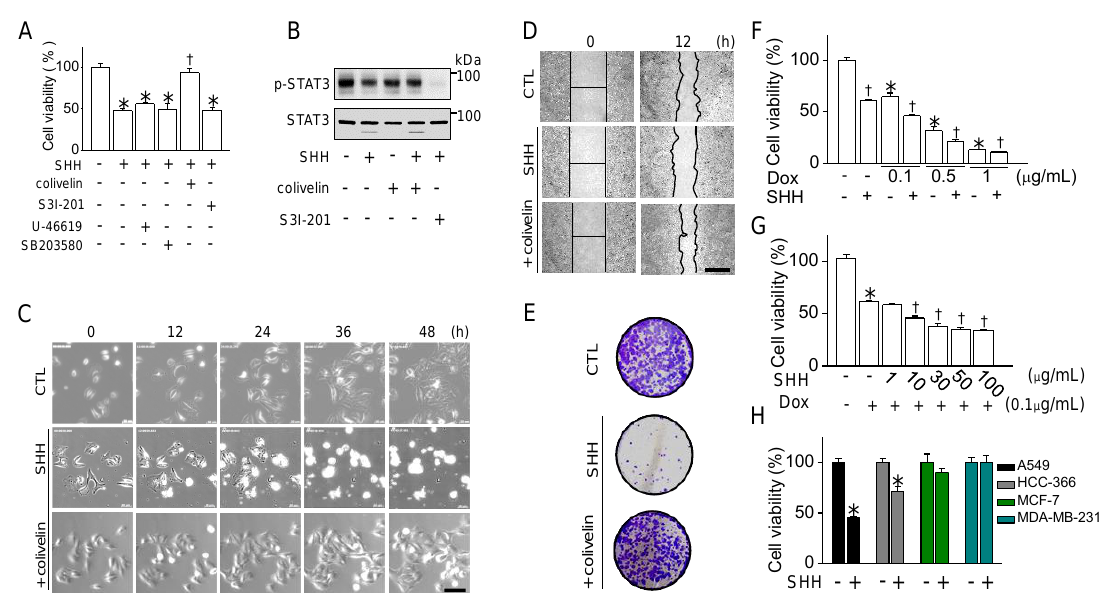
Figure 6. Anti-cancer effect of SHH on A549 cells through inhibition of STAT3 activity. ( A ) Effect of the p38 and STAT3 modulators on SHH-induced cell death. Cells were exposed to SHH (100 μg/mL) for 48 h, and the modulators were pretreated for 1 h. Each bar represents the mean ± SD of four independent experiments ( n = 4). * p < 0.05 compared to the control (no treatment). † p < 0.05 compared to SHH only treatment. ( B ) SHH-induced downregulation of STAT3 activity. SHH was added to A549 cells for 8 h. Total protein (35 μg of protein per lane) was analyzed by immunoblotting assay. ( C ) Real-time images of A549 cells were recorded for 48 h with and without colivelin. ( D ) Effect of colivelin on SHH-induced inhibition of wound healing. Phase-contrast images of wound areas at 0 and 12 h after wounding of A549 cells. ( E ) Reduction of SHH-induced decrease in colony formation of A549 cells by colivelin. Cells were exposed to SHH and colivelin for 48 h. After washing off the chemicals, the cells were further cultured for 10 days for colonization. ( F , G ) Synergistic effect of SHH on doxorubicin-induced cell death. Cells were treated with the indicated concentrations of doxorubicin and/or SHH for 48 h. Different concentrations of doxorubicin ( F ) and SHH ( G ). ( H ) Different effects of SHH between non-small cell lung cancer (NSCLC) and breast cancer cells. The cells were exposed to SHH for 48 h. Each bar represents the mean ± SD of four independent experiments ( n = 4). * p < 0.05 compared to no treatment with chemicals. † p < 0.05 compared to each corresponding control.